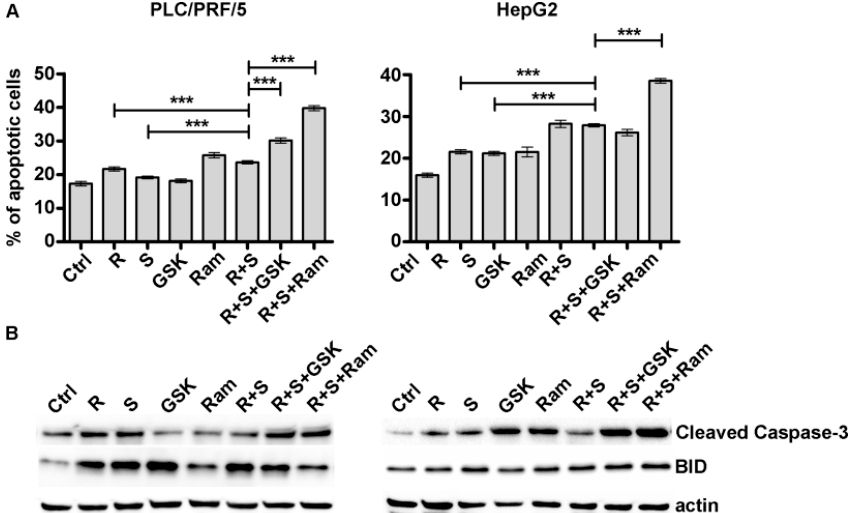
Figure 3. GSK1838705A and ramucirumab potentiate the inhibitory effects of Sorafenib/Regorafenib combination on HCC cell apoptosis. PLC/PRF/5 and HepG2 cells treated respectively with 2.5 μ M and 1 μ M sorafenib, 1 μ M and 0.1 μ M regorafenib, 3 μ M GSK1838705A and 400 μ M ramucirumab administrated as single or combined treatments. ( A ) Muse Annexin V Cell Assay was assessed after 48h. Three independent experiments were performed and the results are expressed as means ± SD. *** p < 0.0001. ( B ) Western blotting showing the expression levels of cleaved Caspase-3 and BID after 48 h single or combined treatments.